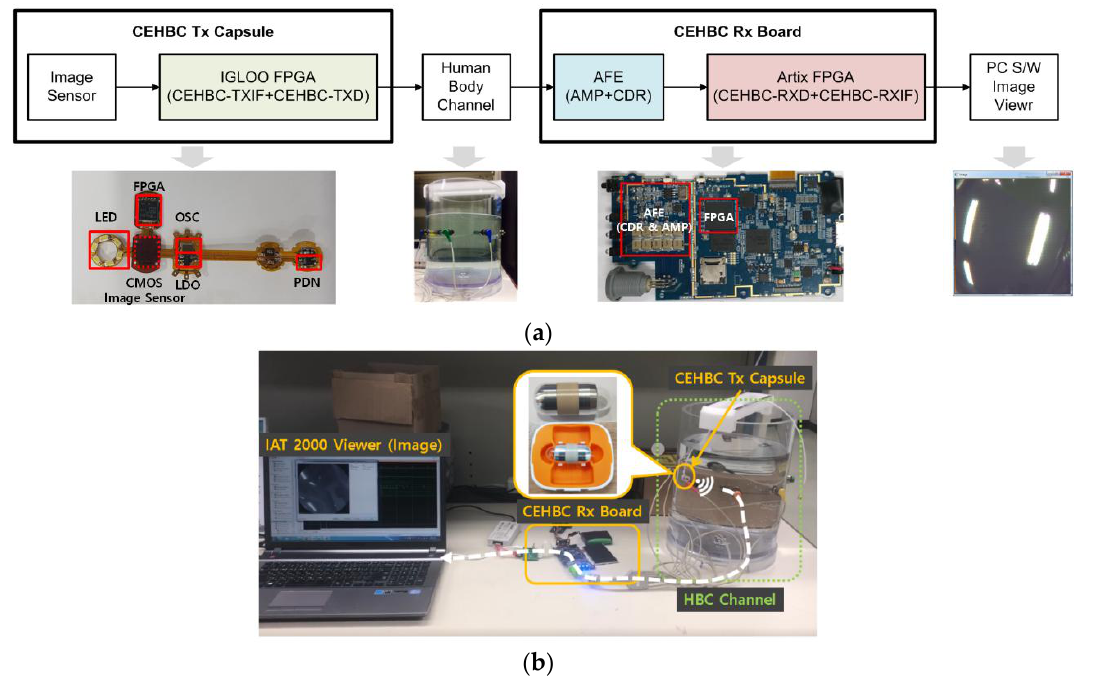
Figure 9. Measurement environment: ( a ) Block-diagram of the CEHBC transceiver system for measurement; ( b ) Measurement environment of the implemented CEHBC system.